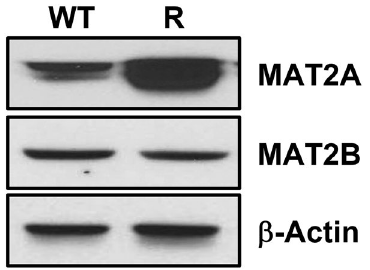
Figure 5. Western blot analysis comparing parental FaDu cells (WT) compared to MTDIA-resistant FaDu cells (R). MAT2A expression is increased in FaDu resistant cells while MAT2B levels are unchanged. MTDIA resistance is linked to MAT2A overexpression and increased capacity for SAM production. The doublet appearance of the MAT2A band is consistent with prior reports. Unedited data is shown in Figure S5 32